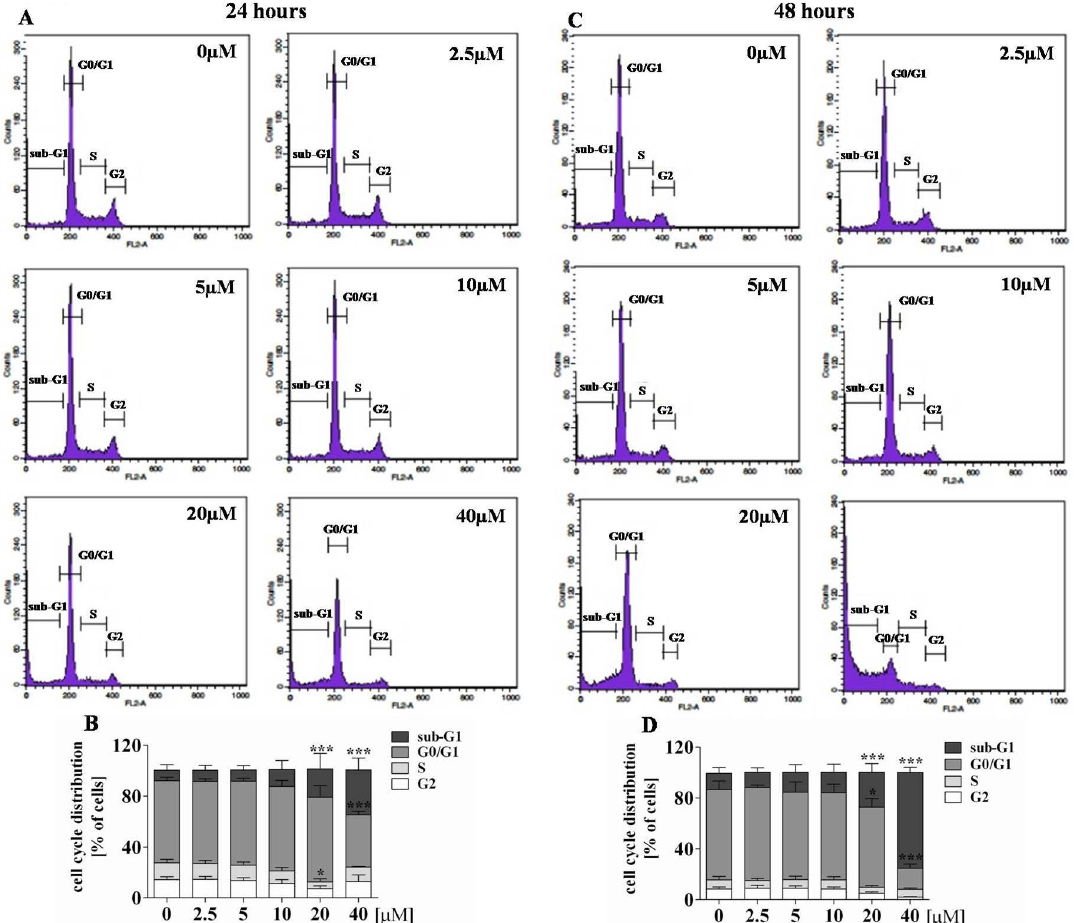
Figure 5. E ff ect of compound 3a on cell cycle distribution in the A549 cell line. After the treatment with various concentrations of compound 3a for 24 and 48 h, the cells were stained with propidium iodide and analyzed by flow cytometry. Representative DNA histograms after 24-h ( A ) and 48-h ( C ) treatment. Statistical analysis of the percentages of cells in the sub-G1, G0 / G1, S, and G2 phases after 24-h ( B ) and 48-h ( D ) treatment. Data ( n = 6 for each concentration) are presented as the mean ± SD of three independent experiments; * p < 0.05, ** p < 0.01 and *** p < 0.001 in comparison to the control; one-way ANOVA